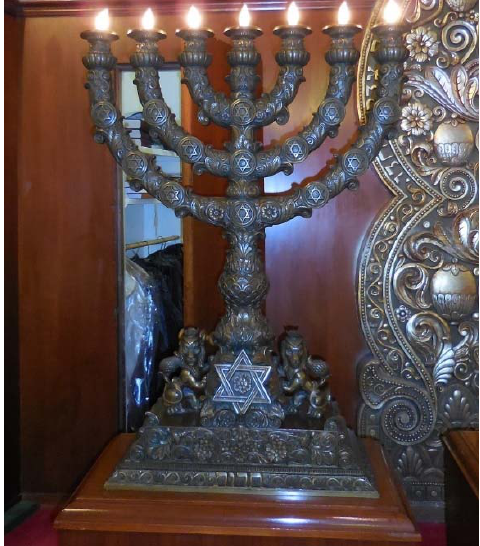
Figure 8. Menorah, Forest Hills Jewish Center.